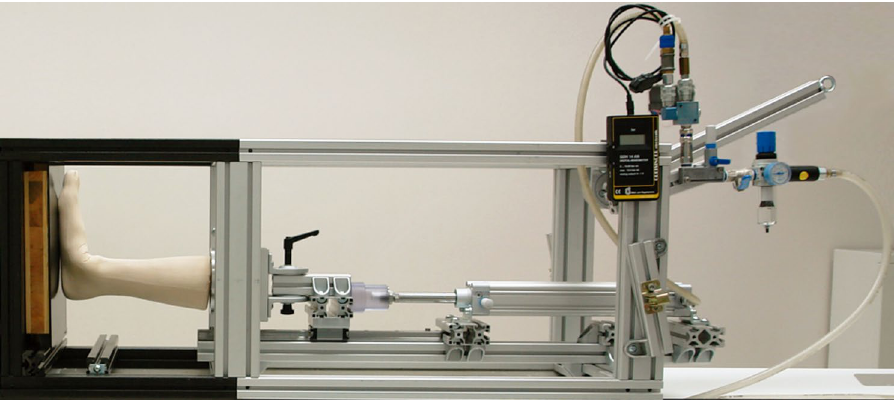
Figure 1. Custom-made loading frame with an artificial lower leg mounted for CT scanning under weightbearing in neutral foot position. The distal end of the frame is made out of radiolucent composite material, the main part is made out of aluminum. A pneumatic cylinder is connected to a compressed air system at the proximal end of the frame.